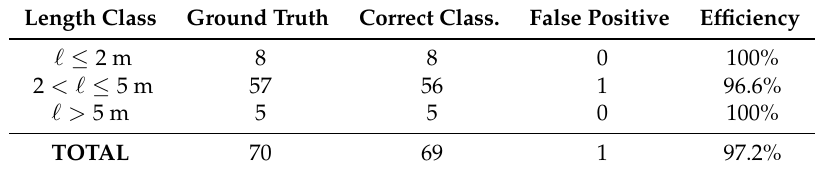
Table 4. Example of classification with respect to length ( (cid:96) ). Analysis performed for lower lane